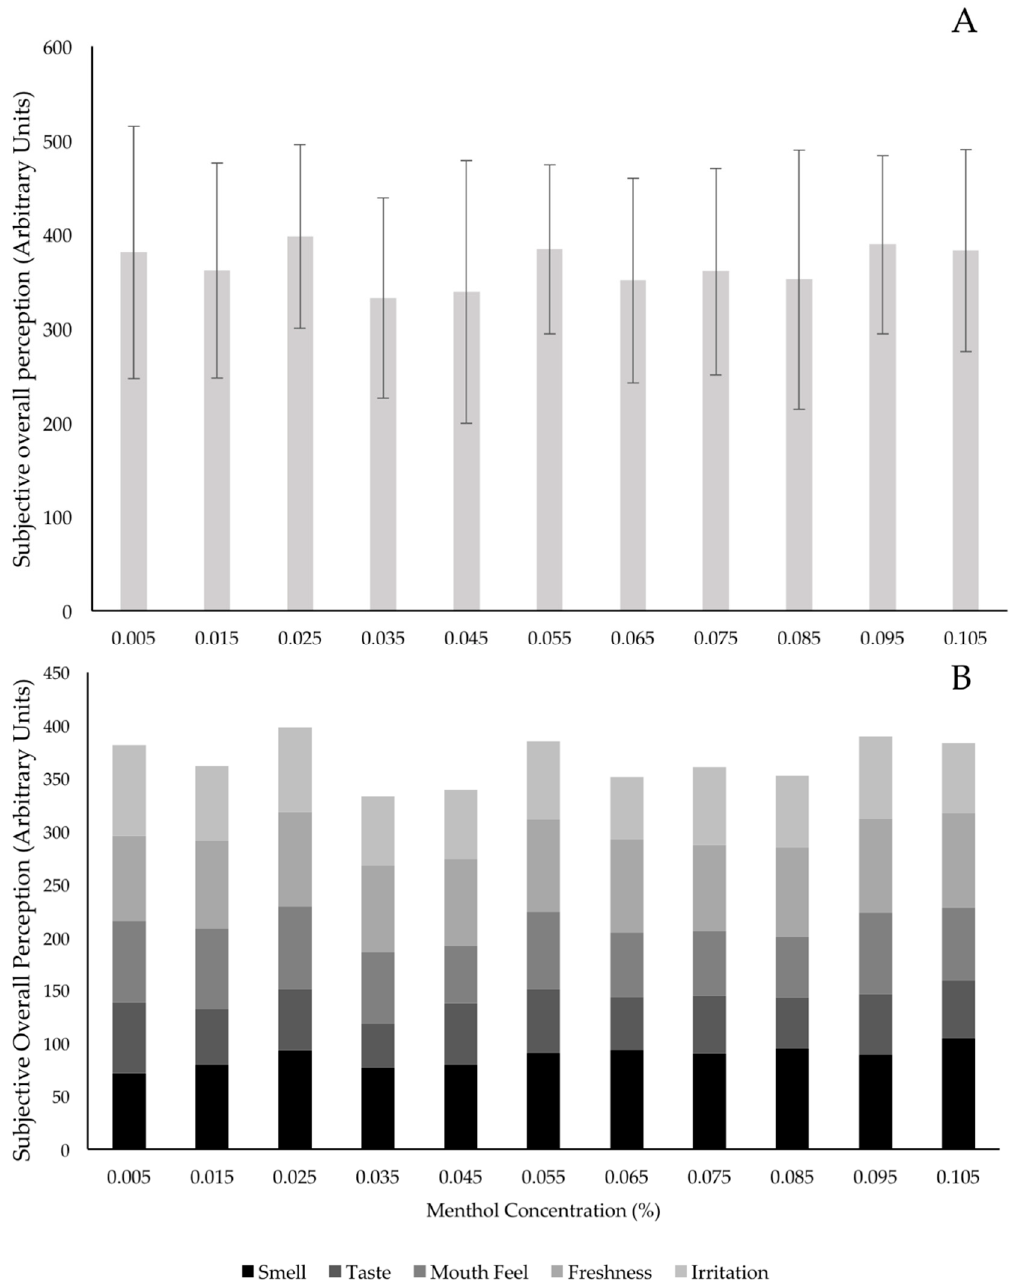
Figure 1. Subjective overall preference for each menthol concentration (%), expressed as Mean VAS rating per solution concentration ± 1 S.D ( Panel A ) and as a sum of constituent mean VAS for each reported characteristic ( Panel B ).